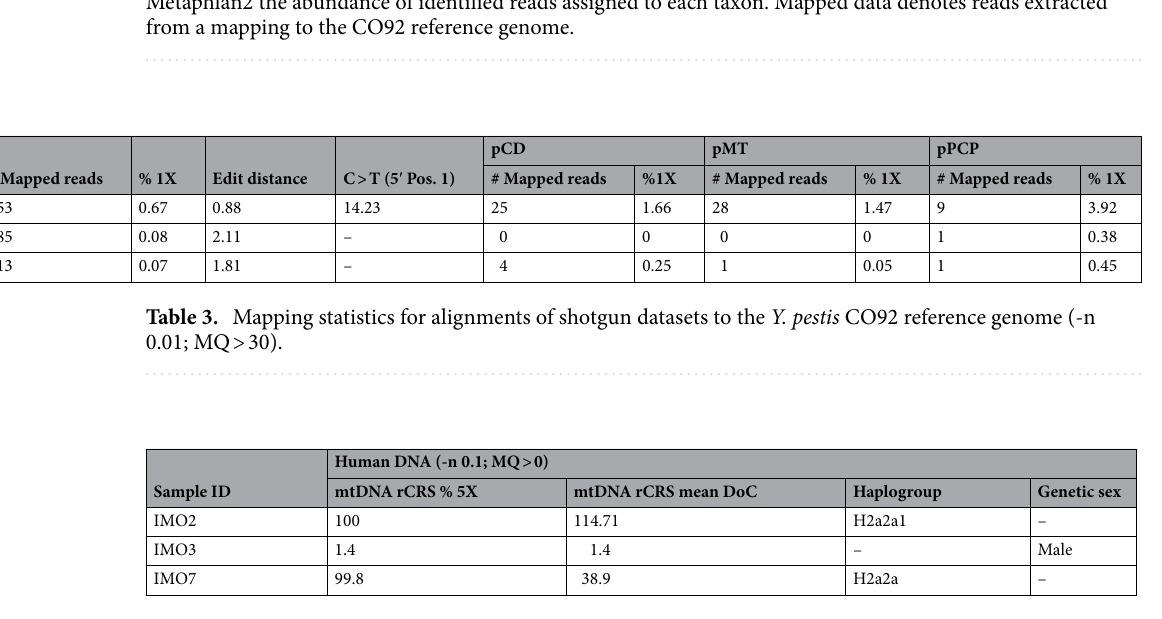
Table 4. Mapping statistics for alignments of shotgun datasets to the human mitochondrial DNA rCRS built and the human allososmes